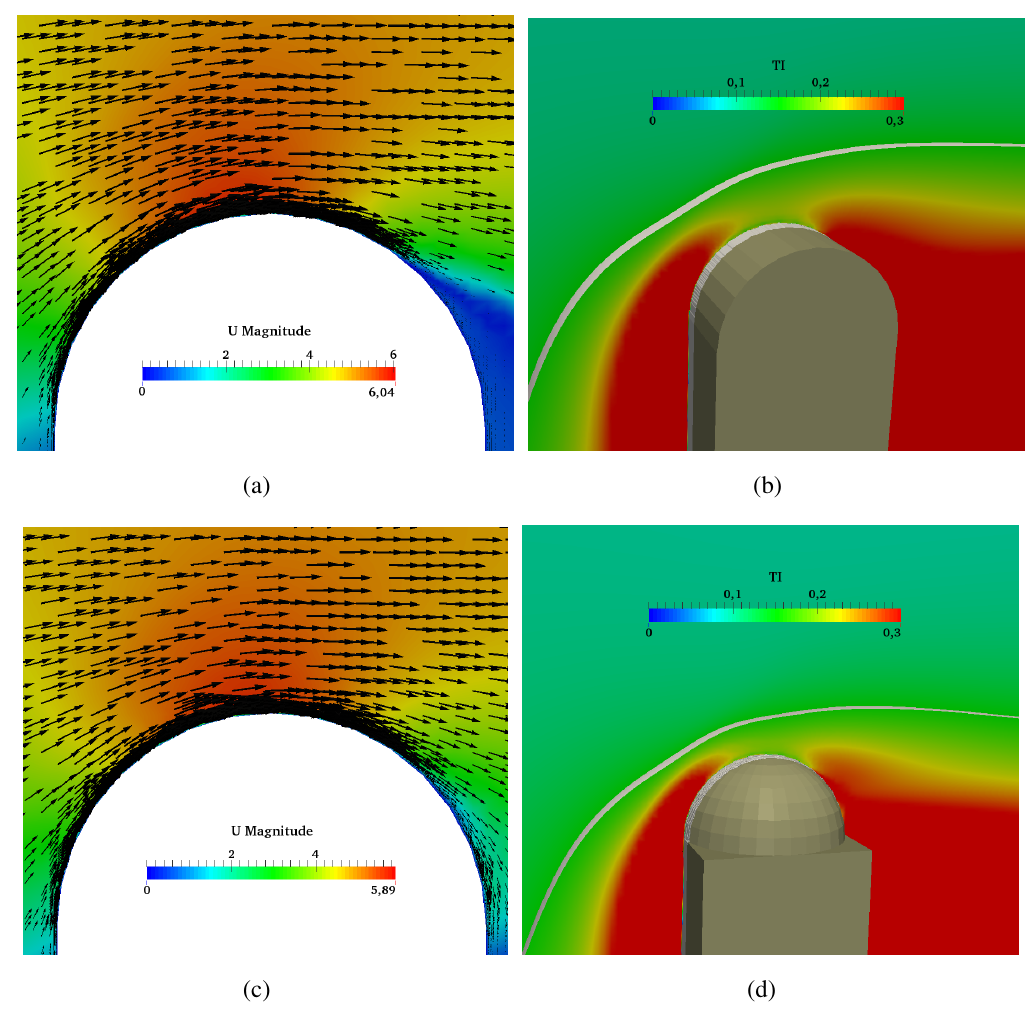
Figure 13. Comparison of U and T I fields on the roof for the state-of-the-art cases: curved roofs. ( a ) U field vaulted roof; ( b ) T I field vaulted roof; ( c ) U field spherical Abohela; ( d ) T I field spherical